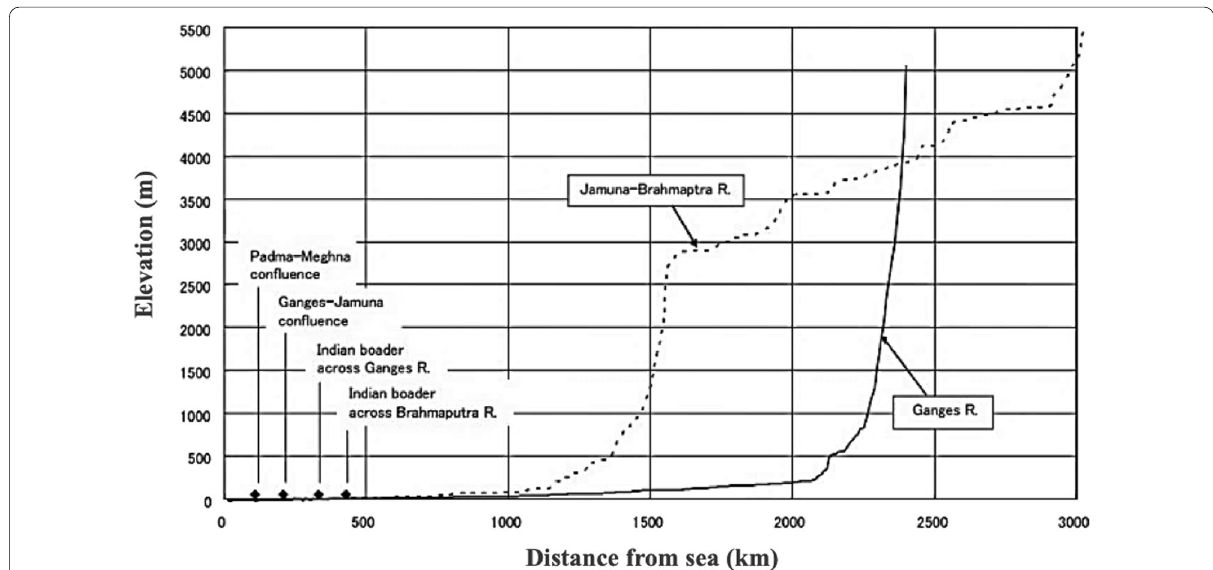
Fig. 4 Longitudinal profiles of Ganges–Brahmaputra–Meghna showing the entire flow path. Compiled from several sources (JICA report 2005; Quamruzzaman et al.